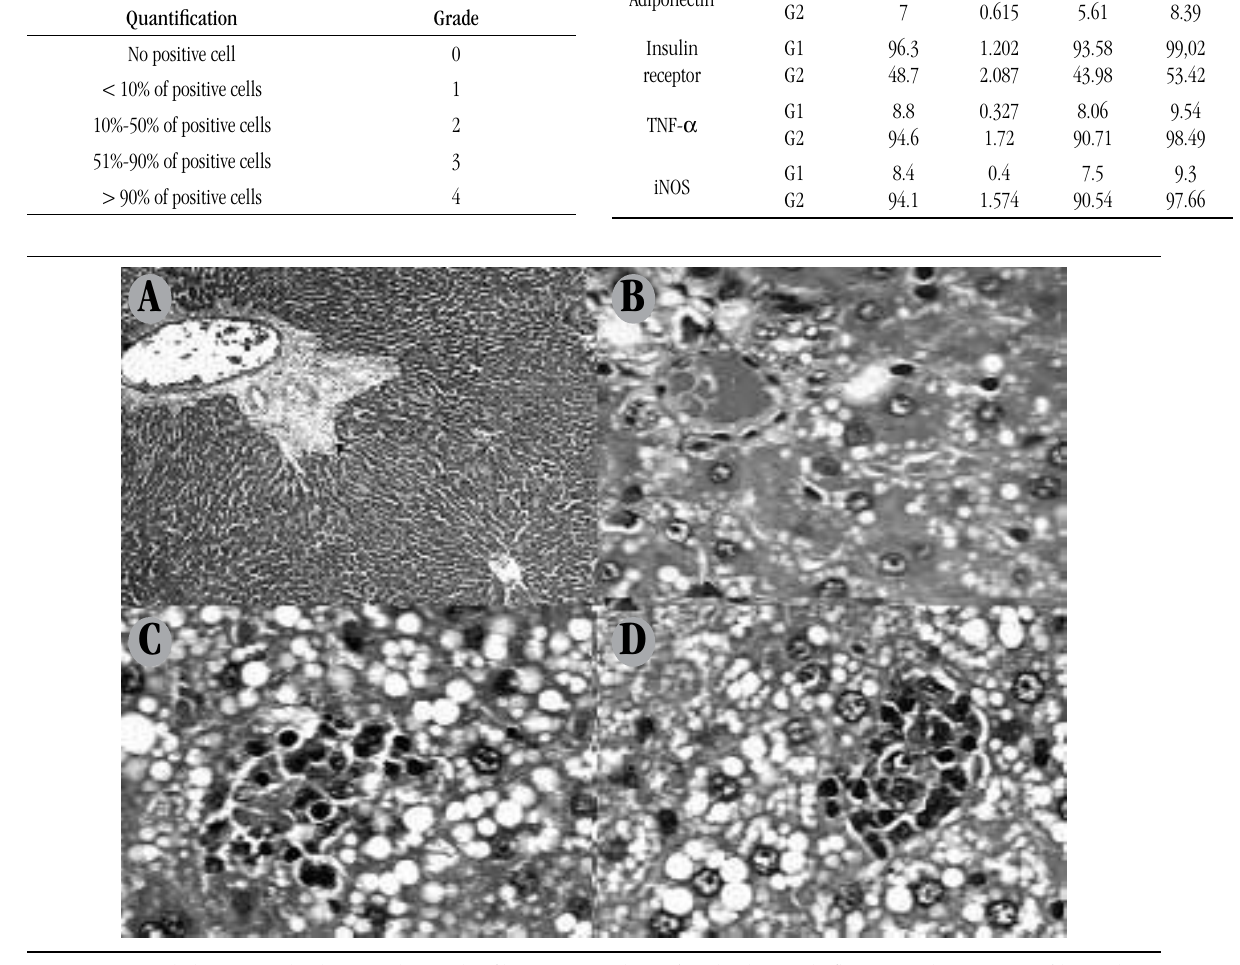
figurE 1 – Isomorphic hepatocytes, trabeculation, portal space with no fibrous expansion, absence of portal and periportal inflammation in hepatic specimen of the control group A) presence of moderate microvesicular steatosis in 1, in hepatic specimen of animal on high-fat diet; B) severe macrovesicular steatosis associated with mixture inflammatory infiltrate in 2, in hepatic specimen of animal on high-fat diet; C) presence of microgranuloma in hepatic specimen of animal on high-fat diet; D) hematoxylin and eosin 40×; B-D: hematoxylin and eosin